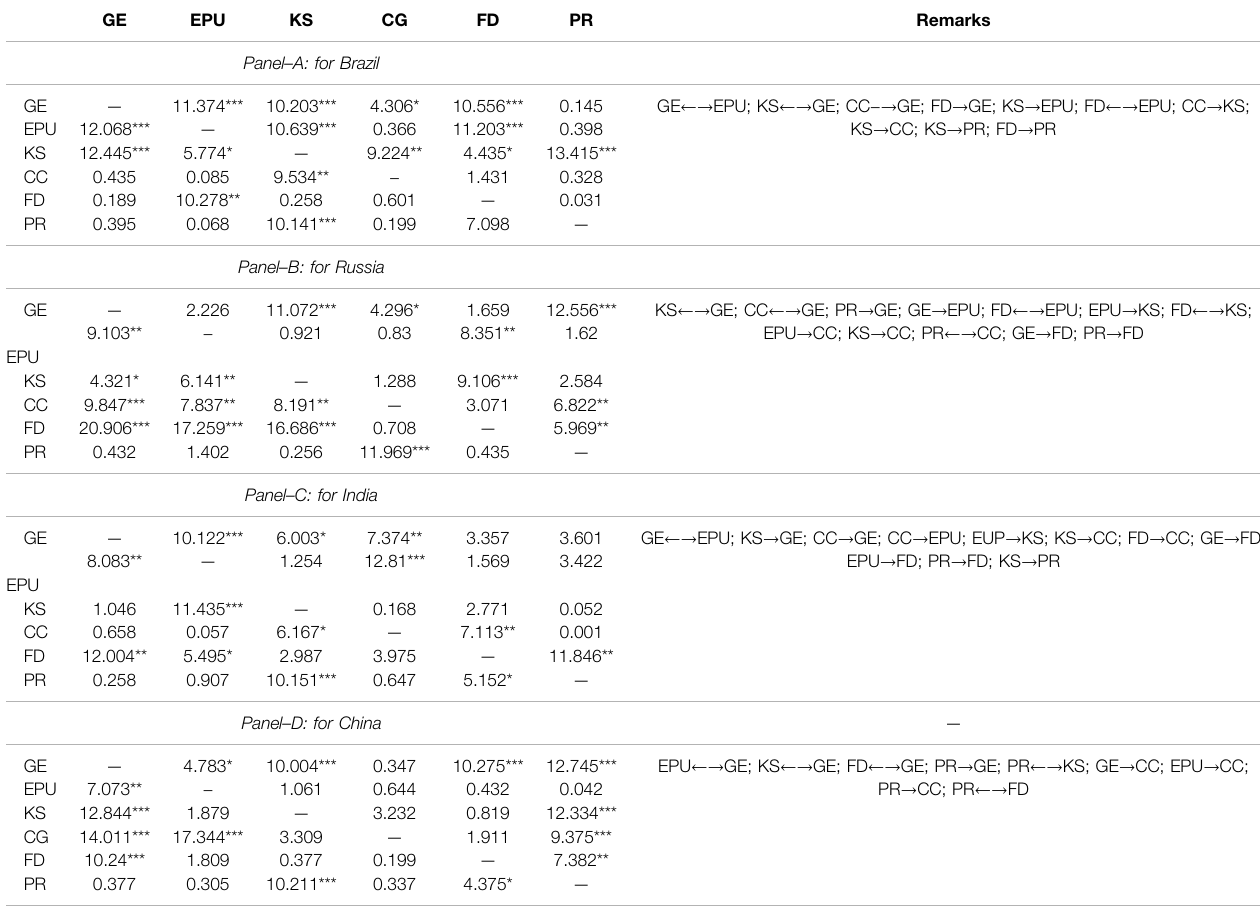
TABLE 8 | Results of Toda − Yamamoto causality test (dmax = 2).